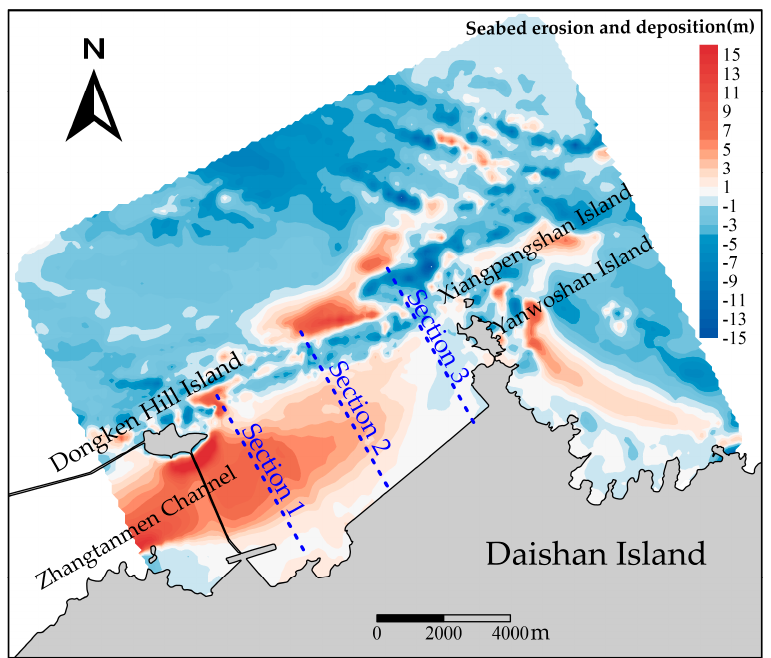
Figure 6. Comparison of local depth before and after the reclamation project of Xiken Hill − Dongken Hill Seawall and DongKen Hill − Daishan Seawall (Sections 1 − 3 are the selected sections for seabed erosion and deposition veri fi cation).